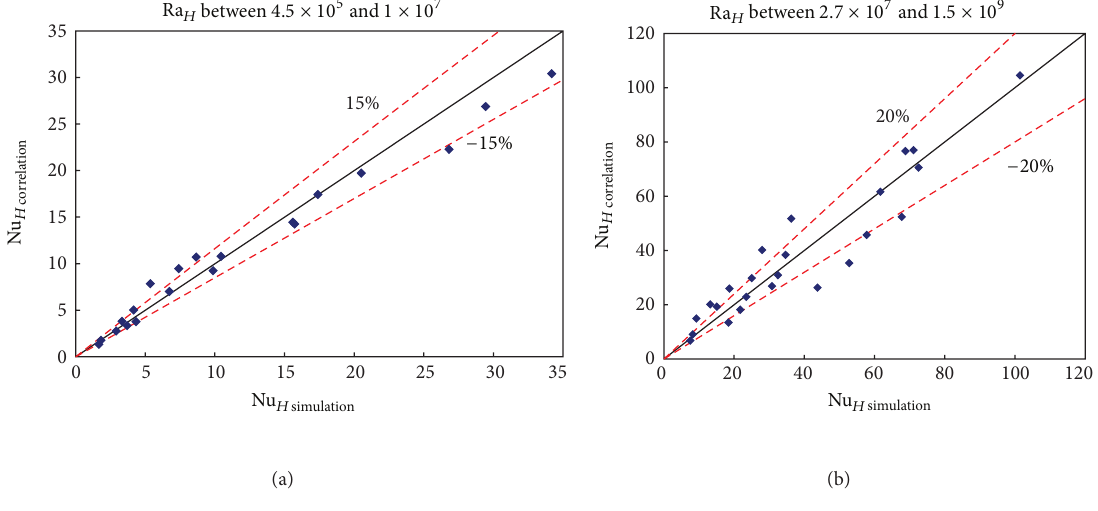
and Nu 𝐻 simulation correlation